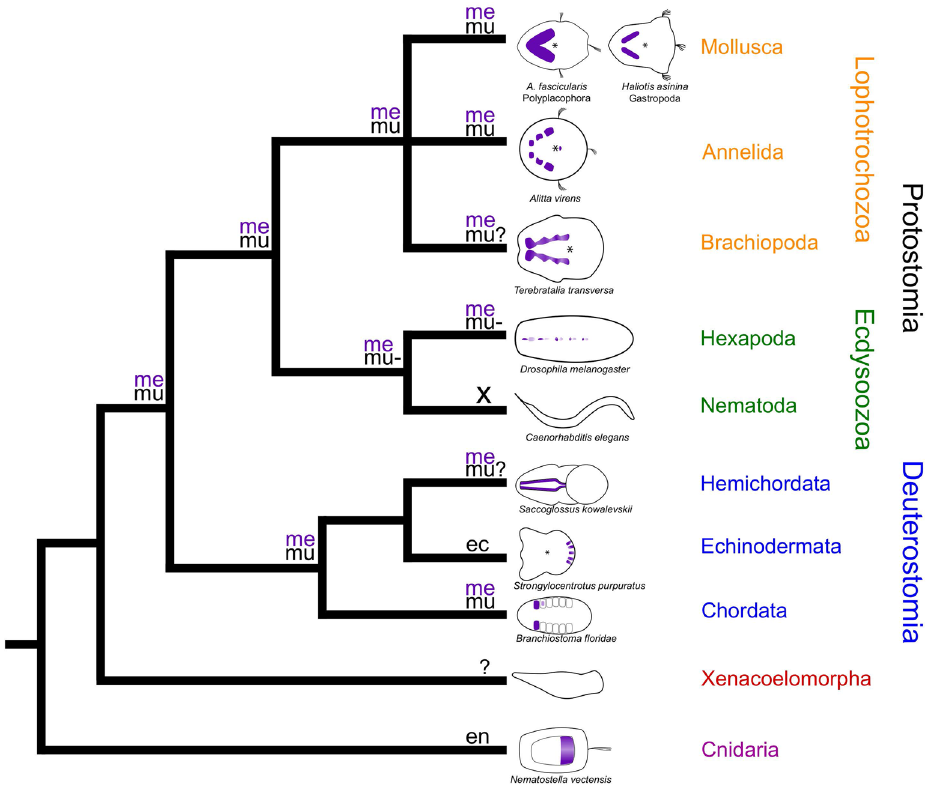
Figure 5. Comparative Mox expression in eumetazoans. Mesodermal domains of Mox expression in purple in schematic representations. Schemes are in ventral view with anterior to the right. ec = expression in ectoderm, en = expression in endoderm, me = expression in mesoderm, mu = Mox expression in developing muscles, mu- = no Mox expression in developing muscles, mu? = Mox expression in developing muscles not investigated, x = no Mox ortholog present. Lophotrochozoa: Mox is expressed in the mesodermal bands of early lophotrochozoan larvae and additionally in a small pre-oral ectomesodermal domain in Alitta virens . Mox